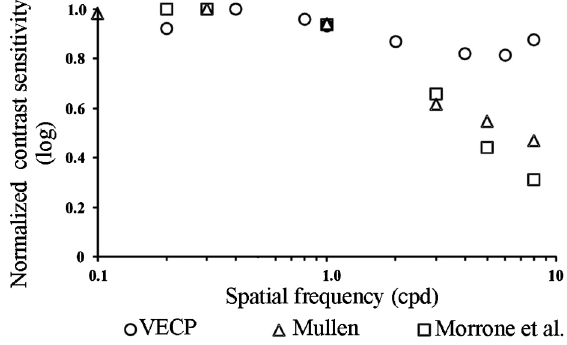
Figure 4. Comparison of red-green contrast sensitivity measured with evoked potentials or psychophysics in three different laboratories. Empty triangles and squares represent data reproduced from the Figure 6 of Mullen (11) and Figure 10 of Morrone et al. (6), respectively. Morrone et al. (6) used a 5-Hz sinusoidal red-green plaid pattern as a stimulus and plotted steady-state visual evoked cortical potential (ssVECP) as a function of Michelson contrast following the Mullen psychophy- sical study of chromatic contrast sensitivity (11). Empty circles are data from the present study, obtained by using 6-Hz sine wave gratings as a stimulus and plotting ssVECP amplitude as a function of pooled cone contrast. Due to the different conditions used in the two studies, the curves were normalized to their peak value to provide a basis for comparison. The results were generally similar up to 2-3 cpd. From 4 cpd onwards the two data sets diverged and those from the present study showed higher values than those of Mullen and Morrone et al. See text for